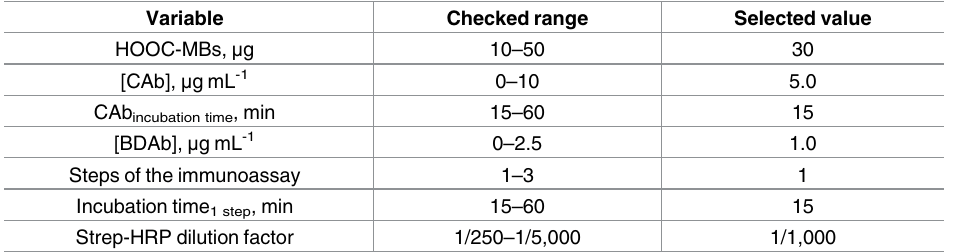
Table 1. Optimization of the experimental variables tested, according to the measuredS/B ratio in the absence and in the presenceof 5,000 pg mL -1 FGFR4 standard solutions, for the preparation of the amperometric immunosensor for FGFR4.